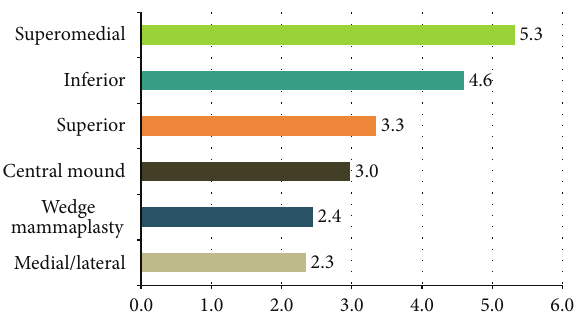
Figure 2: Nipple areolar complex pedicle. Please rank the pedicle most commonly used (1 = most often used, 6 = least often used, average scores out of